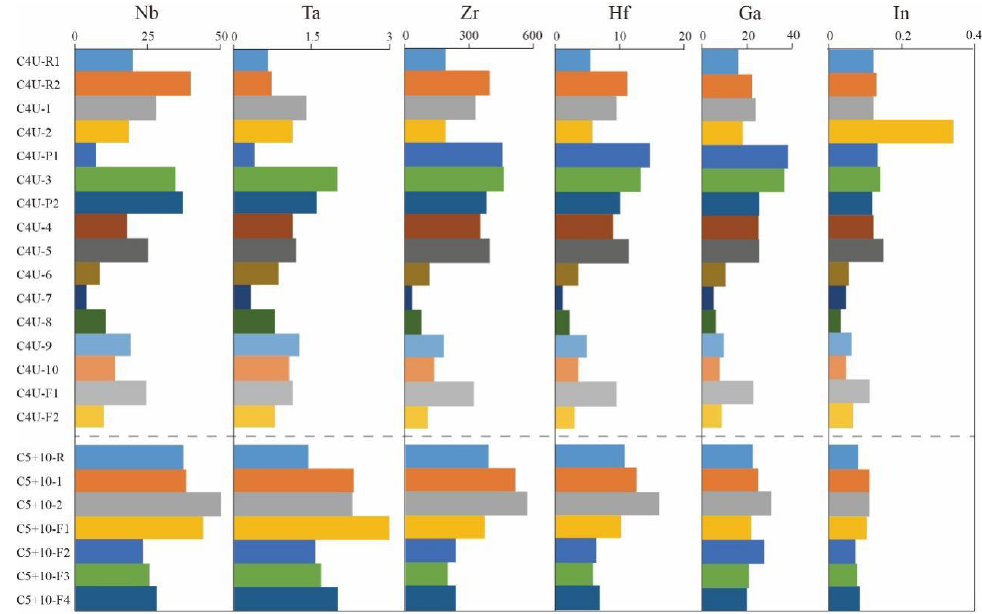
Figure 6. Vertical changes in contents of high-field-intensity elements and non-variable valence chalcophile elements of the two coal seams. Note: Above the dashed line these samples are from the C4-Upper coal seam. Under the dashed line these samples are from C5 + 10 coal samples. All the elements are coal-basic, and the unit of abscissa is µg/g.